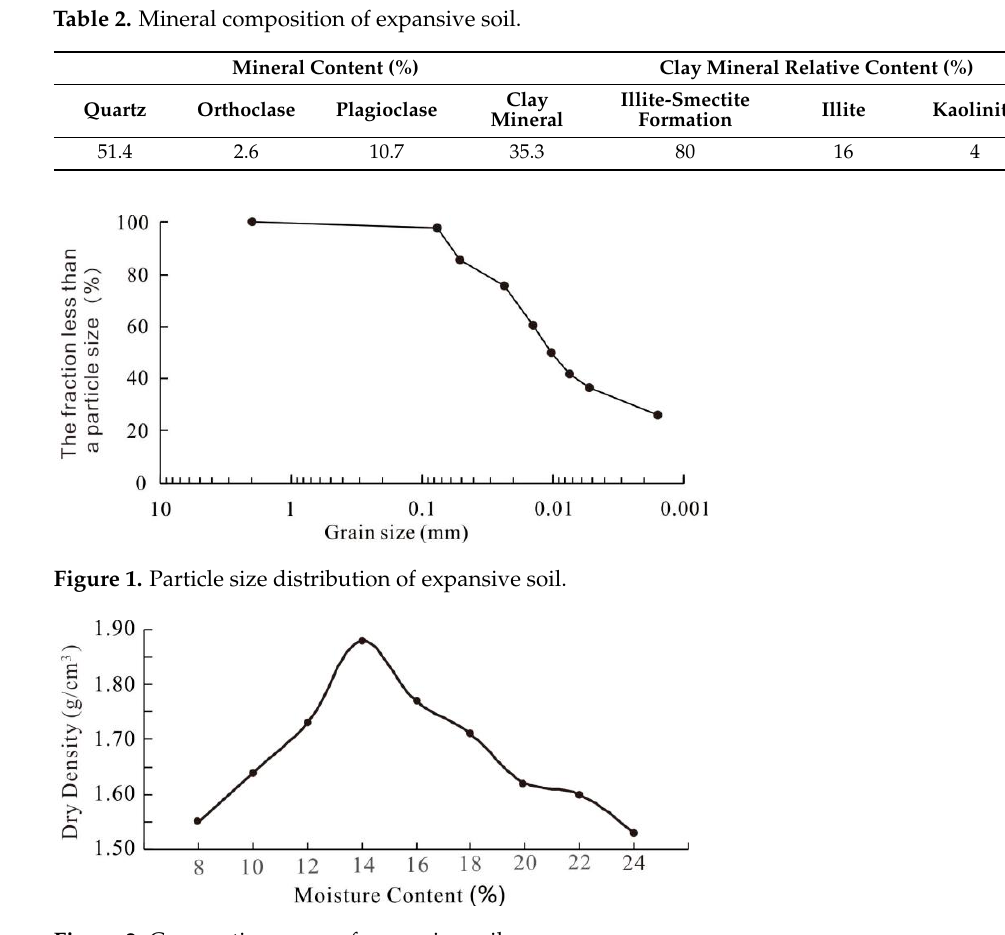
Figure 2. Compaction curve of expansive soil.